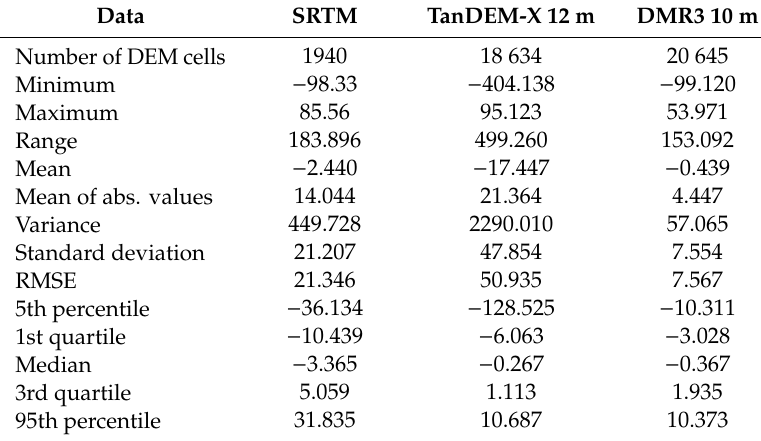
Table 2. Summary statistics of vertical di ff erences of SRTM, TanDEM-X and DMR3 DEM (DODs) calculated with respect to the TLS–UAV-SfM DEM for original resolutions of compared DEMs (elevation values in